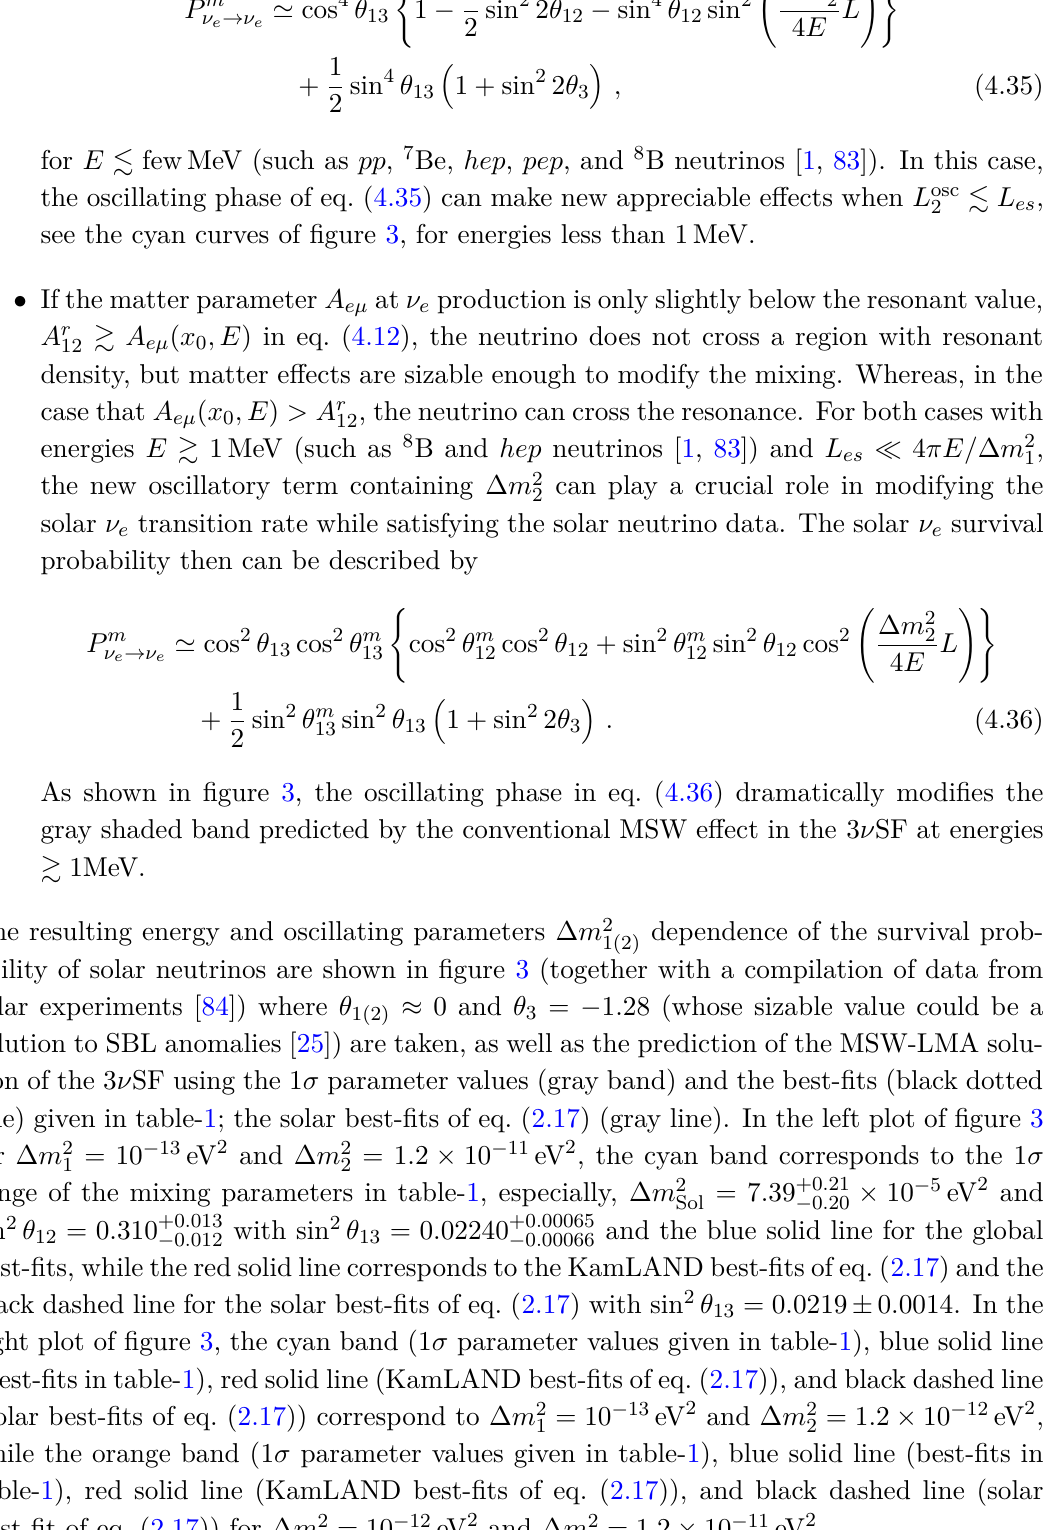
black dashed line for the solar best-fits of eq. (2.17) with sin 2 θ = 0 . 0219 ± 0 . 0014 . In the 13 right plot of figure 3, the cyan band ( 1 σ parameter values given in table-1), blue solid line (best-fits in table-1), red solid line (KamLAND best-fits of eq. (2.17)), and black dashed line (solar best-fits of eq. (2.17)) correspond to ∆ m 2 = 10 − 13 eV 2 and ∆ m 2 = 1 . 2 × 10 − 12 eV 2 , 1 2 while the orange band ( 1 σ parameter values given in table-1), blue solid line (best-fits in table-1), red solid line (KamLAND best-fits of eq. (2.17)), and black dashed line (solar best-fit of eq. (2.17)) for ∆ m 2 = 10 − 12 eV 2 and ∆ m 2 = 1 . 2 × 10 − 11 eV 2 1 2